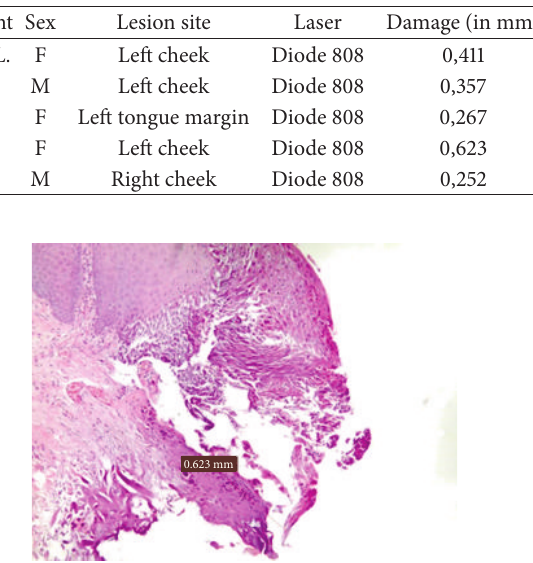
Figure 3: Damage measurement in a fibroma.